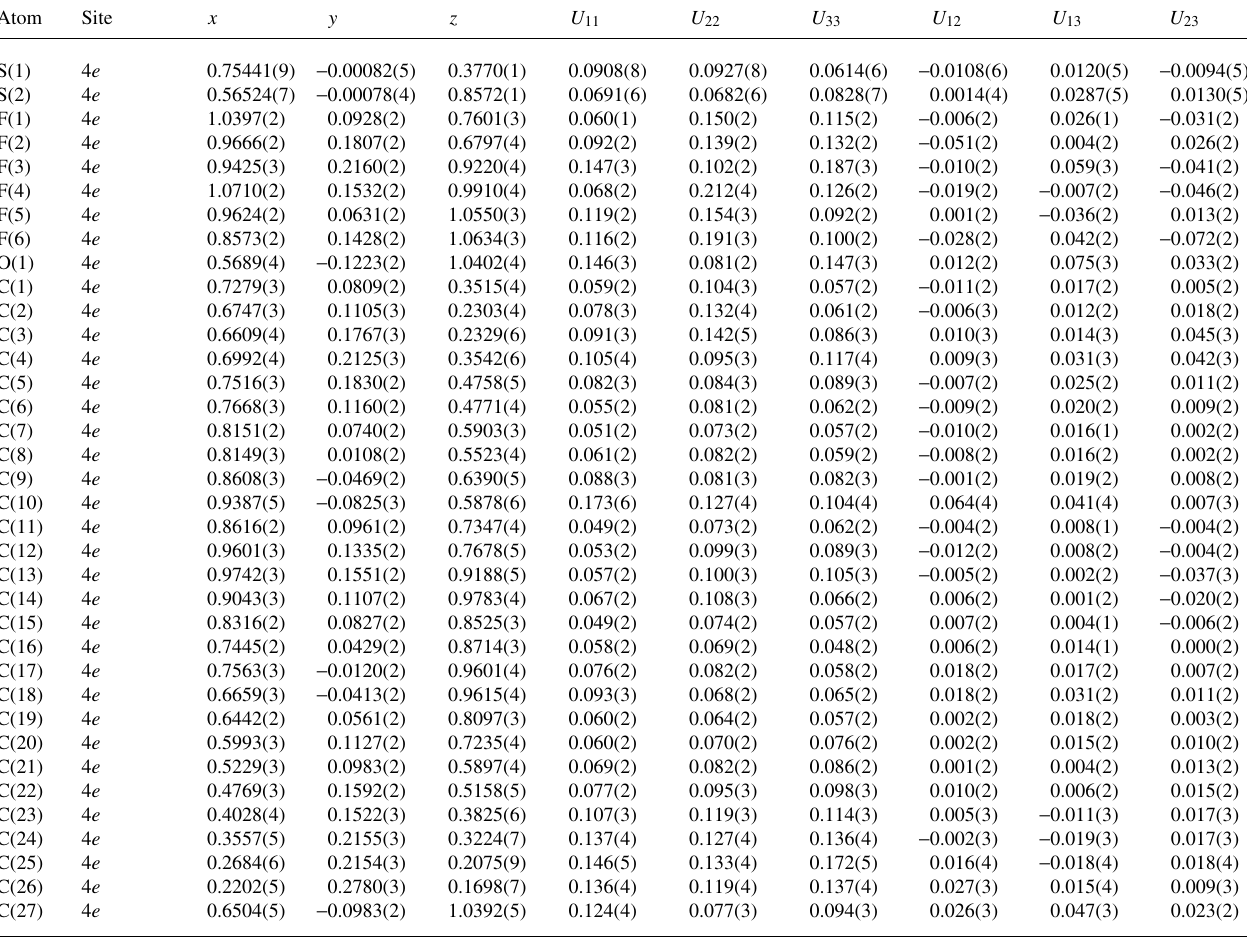
Table 3. Atomic coordinates and displacement parameters (in Å 2 ) .